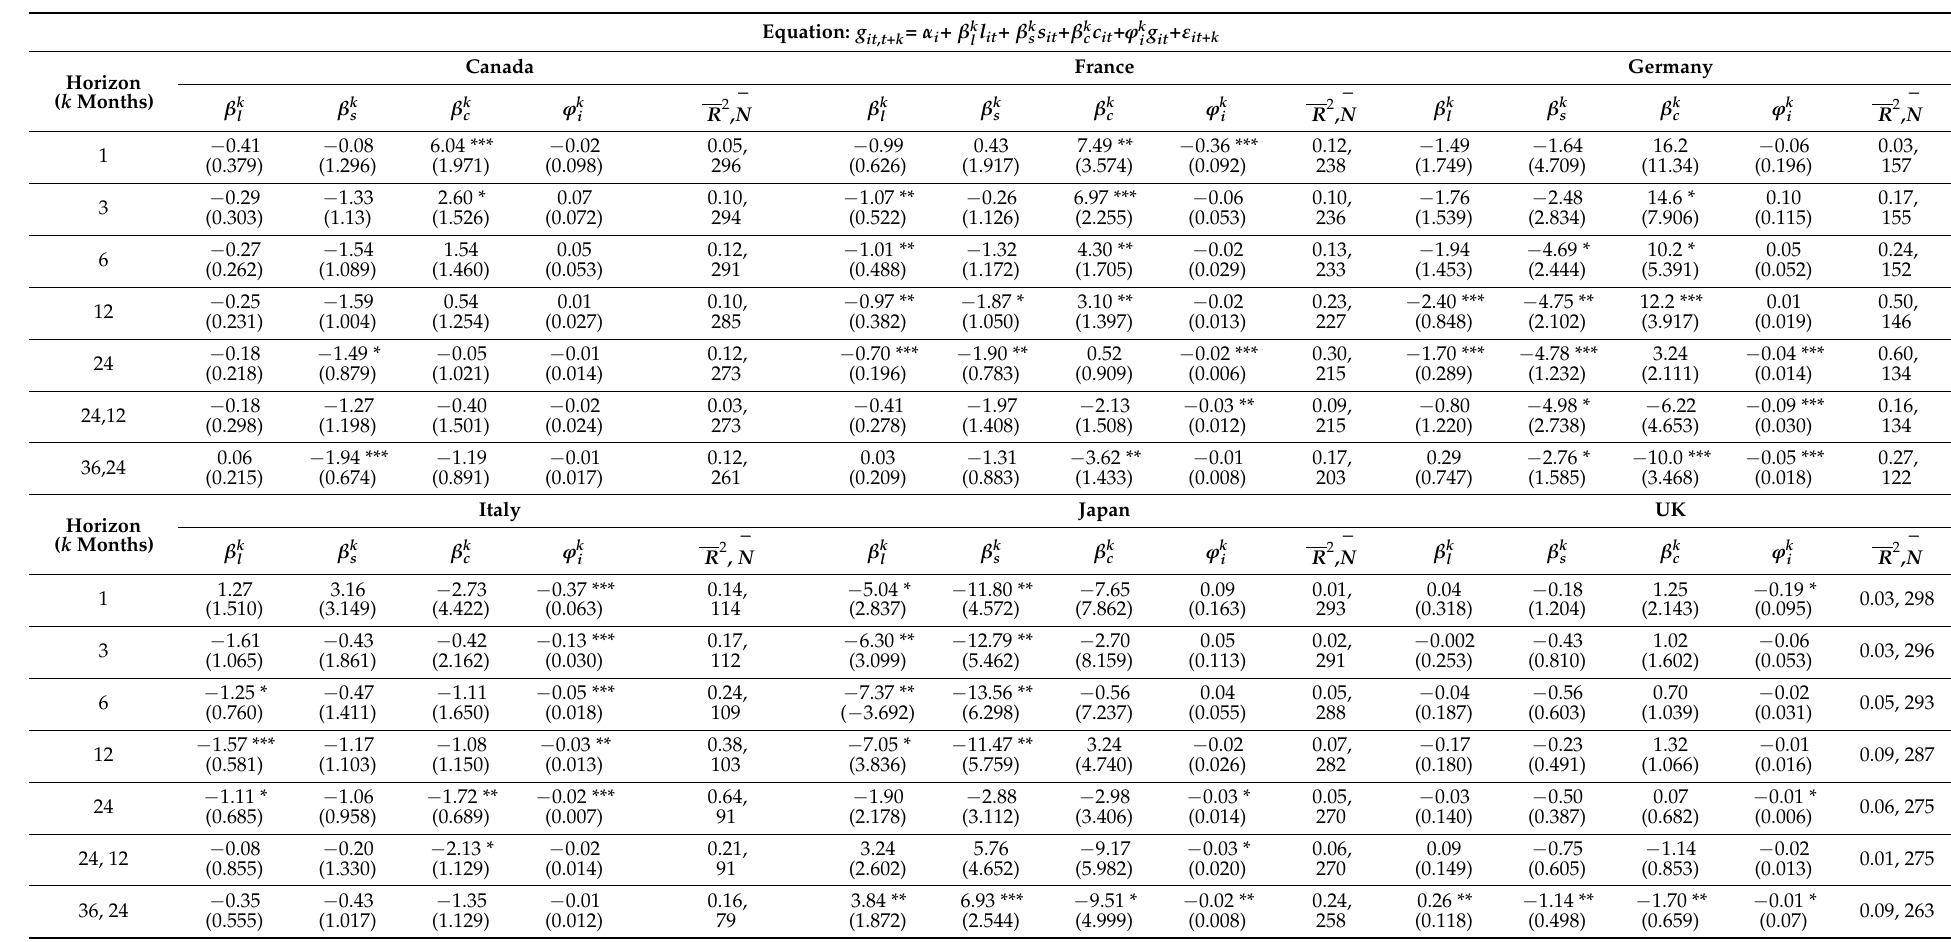
Table A5. Economic activity, levels, slope, curvature, and